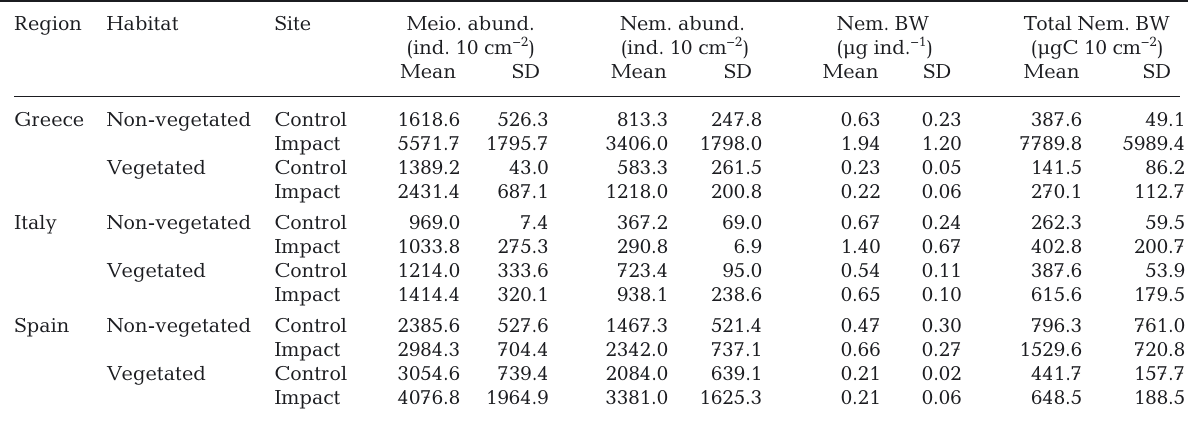
families at the impact sites, while Chromadoridae (Table S1 in the Supplement at www.int-res.com/ (22.8%), Selachinematidae (13.6%) and Desmodori- articles/ suppl/q005p017_supp.pdf), whereas non- dae (10.8%) were the most abundant at the control vegetated sediments contained 32 families, 86 gen- sites. At vegetated impact sites, Daptonema (25.7%, era and 165 species (Table S2 in the Supplement). 4 species), Desmodora (13.4%, 7 species) and Pro - In vegetated sediments, the most common families were Chromadoridae (21.5%, 11 genera and 14 spe- chromadorella (13.1%, 3 species) were the most abun- dant genera, while at control sites, the most abundant cies), Xyalidae (16.2%, 4 genera and 7 species) and were Richtersia (13.4%, 3 species), Prochromadorella Desmodoridae (15.3%, 7 genera and 18 species). (10.2%, 3 species), Desmodora (8.9%, 7 species) and Xya lidae (26.1%), Chromadoridae (20.6%) and Desmodoridae (18.6%) were the most abundant Desmoscolex (6.8%, 3 species). Table 3. PERMANOVA testing for differences between impact and control sites in different habitats and regions in nematode abundance, individual body weight, biomass, maturity index (MI), community composition, index of trophic diversity (ITD), expected species richness (ES51), Shannon-Wiener diversity ( H ’), Margalef’s richness ( D ), and Pielou’s evenness ( J) . R = region; H = habitat; S = site; F = pseudo- F value. All tests were conducted on Euclidean-distance similarity matrices and the residuals were permutated under a reduced model,